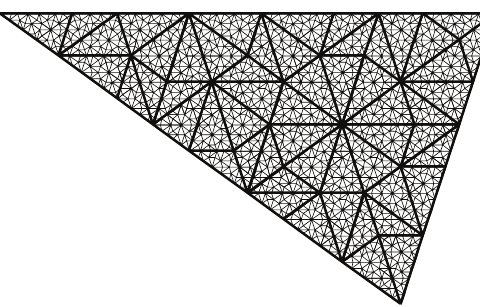
(cid:2) A (cid:3) and Φ 8 1 P